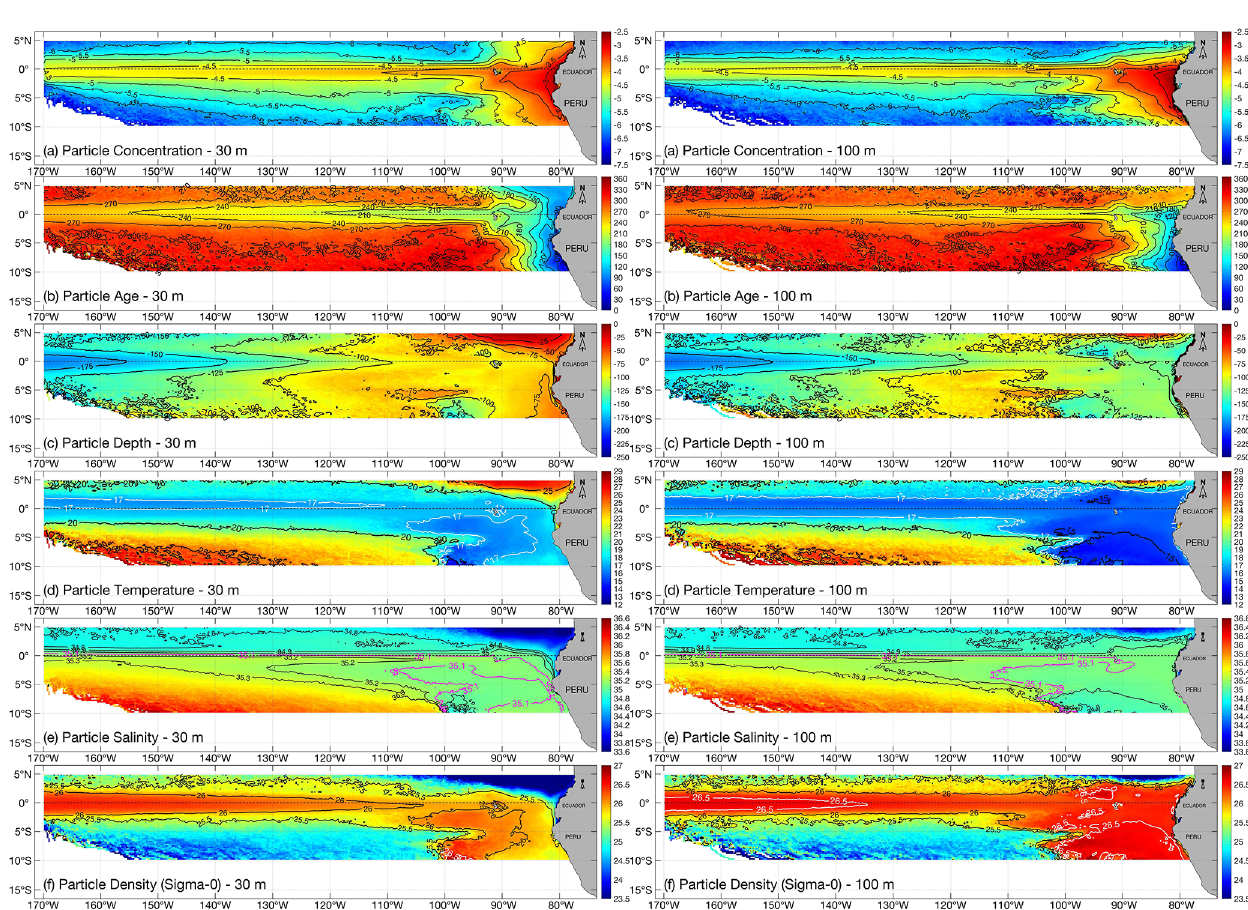
Figure 5. Grand ensemble of back-trajectory data (averaging the 1989–2007 ensembles), for particles backtracked at the end of each month (December–January) at 30m depth (left panel) and 100m depth (right panel) respectively, binning at 0 . 5 ◦ × 0 . 5 ◦ resolution: (a) particle concentration (calculated as a fractional particle presence in log-10 scale, by dividing the number of particle occurrence passing through each grid cell by the total number of particles occurrences during the course of the year); (b) particle age (color bar represents days from 0 to 365 prior to upwelling); (c) particle depth (m); (d) particle temperature ( ◦ C); (e) particle salinity (psu); (f) particle potential density ( σ θ , kgm − 3